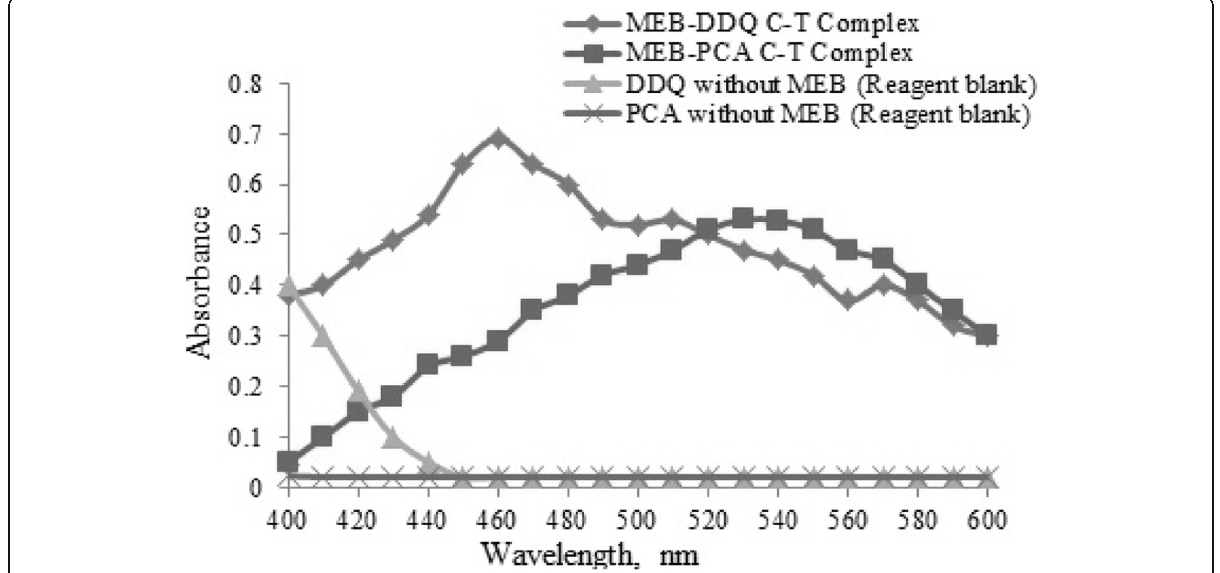
Fig. 2 Absorption spectra of MEB-PCA and MEB-DDQ C-T